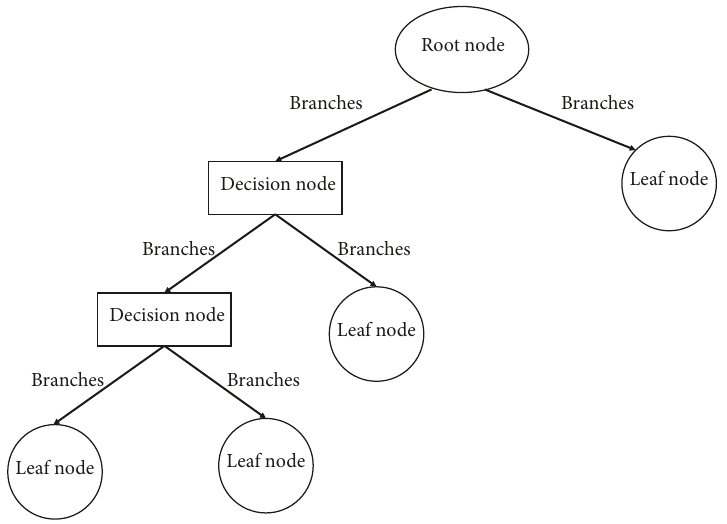
Figure 1: Structure of decision